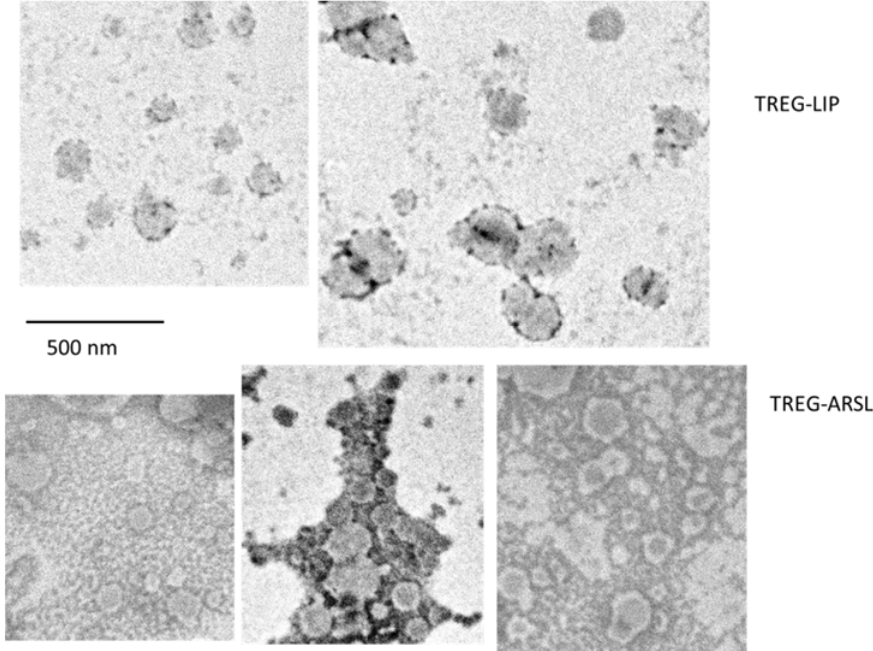
Figure 1. TEM micrographs of TREG ‐ LIP and TREG ‐ ARSL .